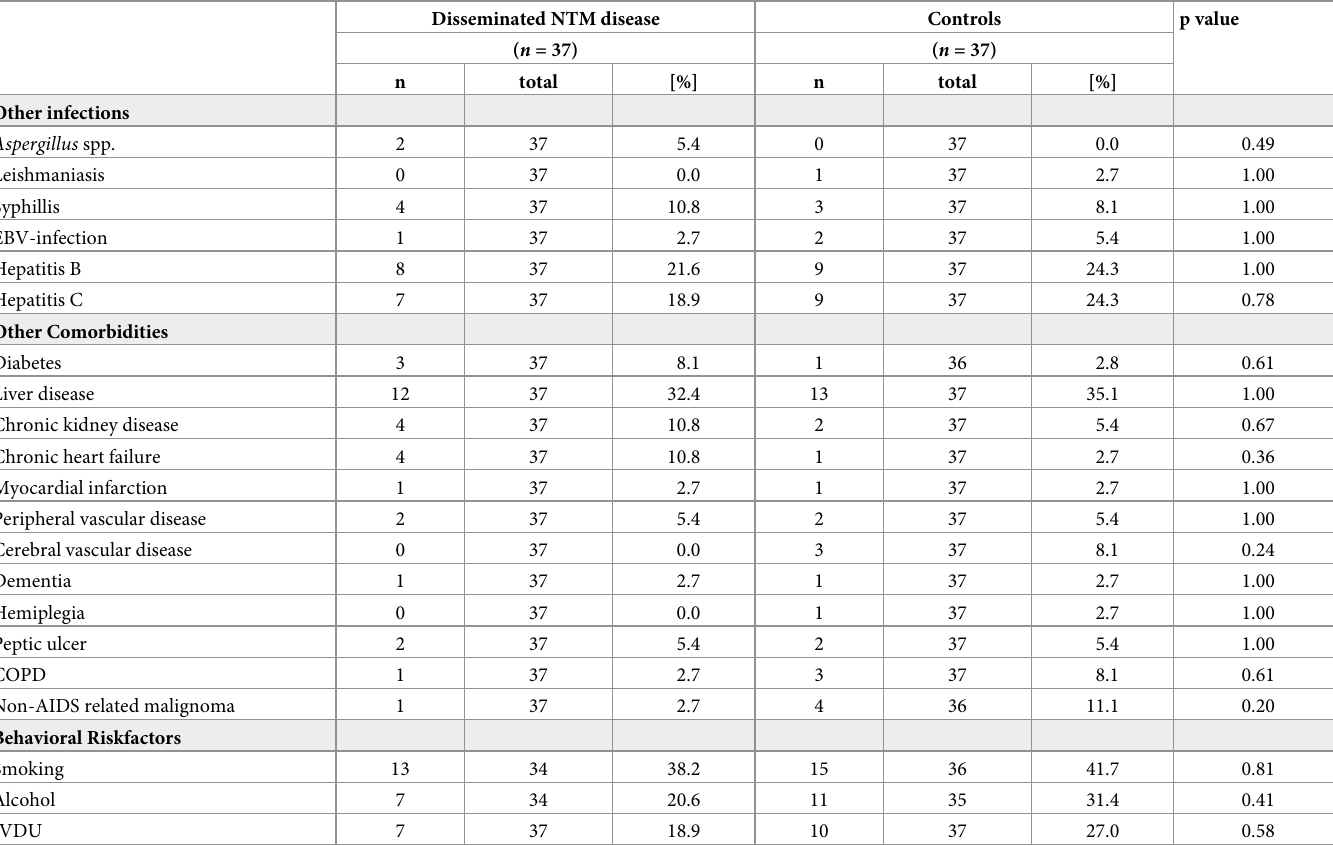
Table 3. Other infections, comorbidities and behavioral risk factors in patients with disseminated NTM disease and